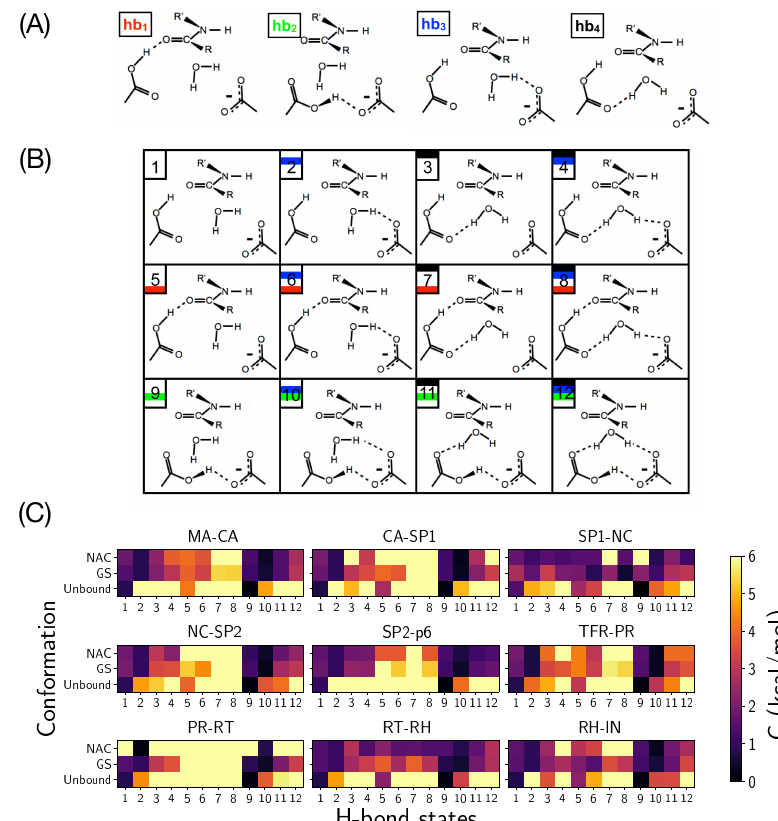
Figure 4. ( A ) Four distinct hydrogen bonds that occur in the HIV-1 protease catalytic site when a nucleophilic water molecule is bound and ( B ) twelve possible combinations of hydrogen bond states that exhibit non-zero density as represented in a previous study [31]. ( C ) Thermodynamic variation of catalytic site hydrogen bond state distribution across different substrates when the nucleophilic water molecule is in the NAC, GS, and unbound